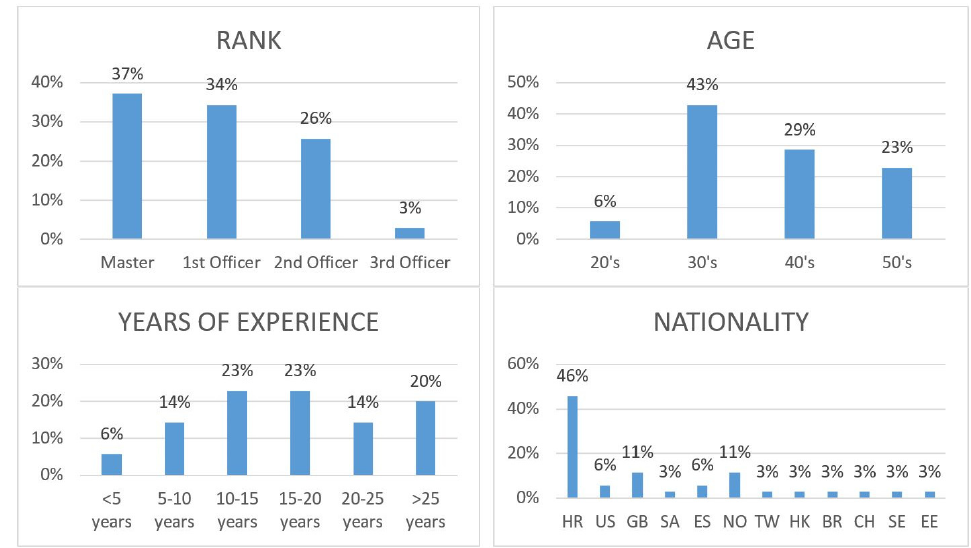
Figure 2. Rank, age, years of experience, and nationality of respondents.